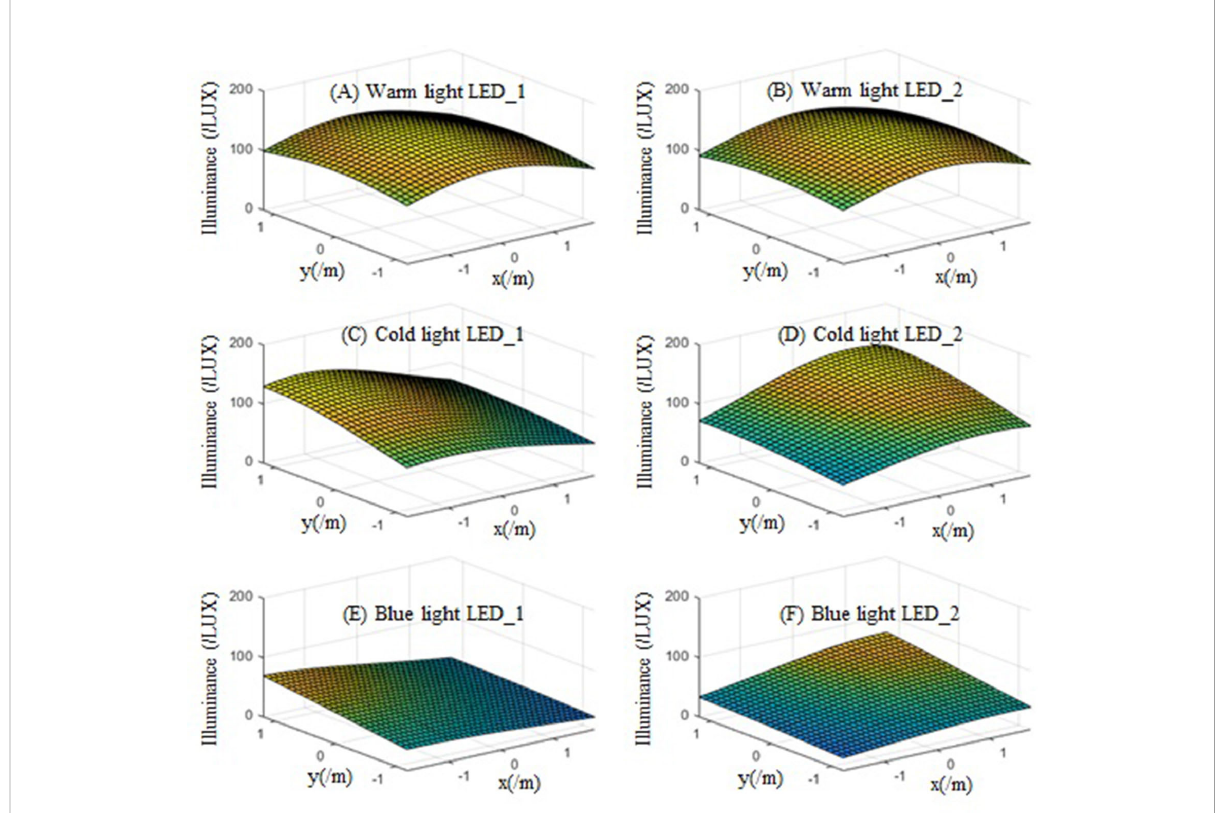
FIGURE 4 The illumination distributions of each single LED lamp with a distance of 3m: (A) the illumination distribution of warm light LED_1 on target surface; (B) the illumination distribution of warm light LED_2 on target surface; (C) the illumination distribution of cold light LED_1 on target surface; (D) the illumination distribution of cold light LED_2 on target surface; (E) the illumination distribution of blue light LED_1 on target surface; (F) the illumination distribution of blue light LED_2 on target